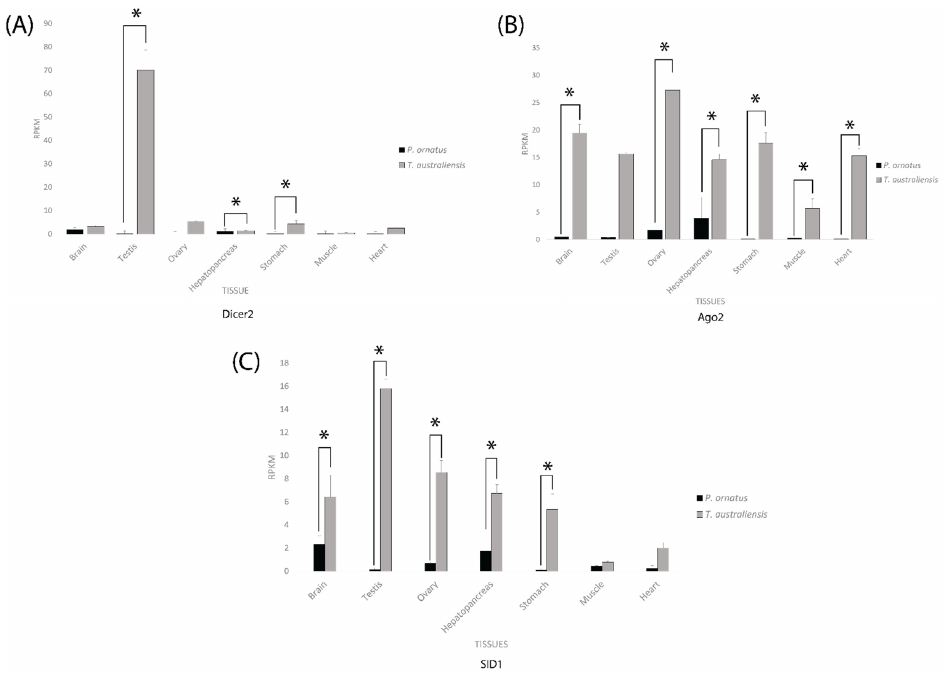
Figure 5. Expression of small interfering RNA (siRNA) pathway genes ( A -Dicer 2, B -Argonaute 2, C-SID1) across adult tissues in Panulirus ornatus (n = 3) and Thenus australiensis (n = 3). Expression is measured in reads per kilobase per million reads (RPKM). Black bar represents tissues from P. ornatus , grey bar represents tissues from T. australiensis . Tissues from left to right are brain, testis, ovary, hepatopancreas, stomach, muscle, and heart. An asterisk represents a statistically significant ( p < 0.05) difference in expression.